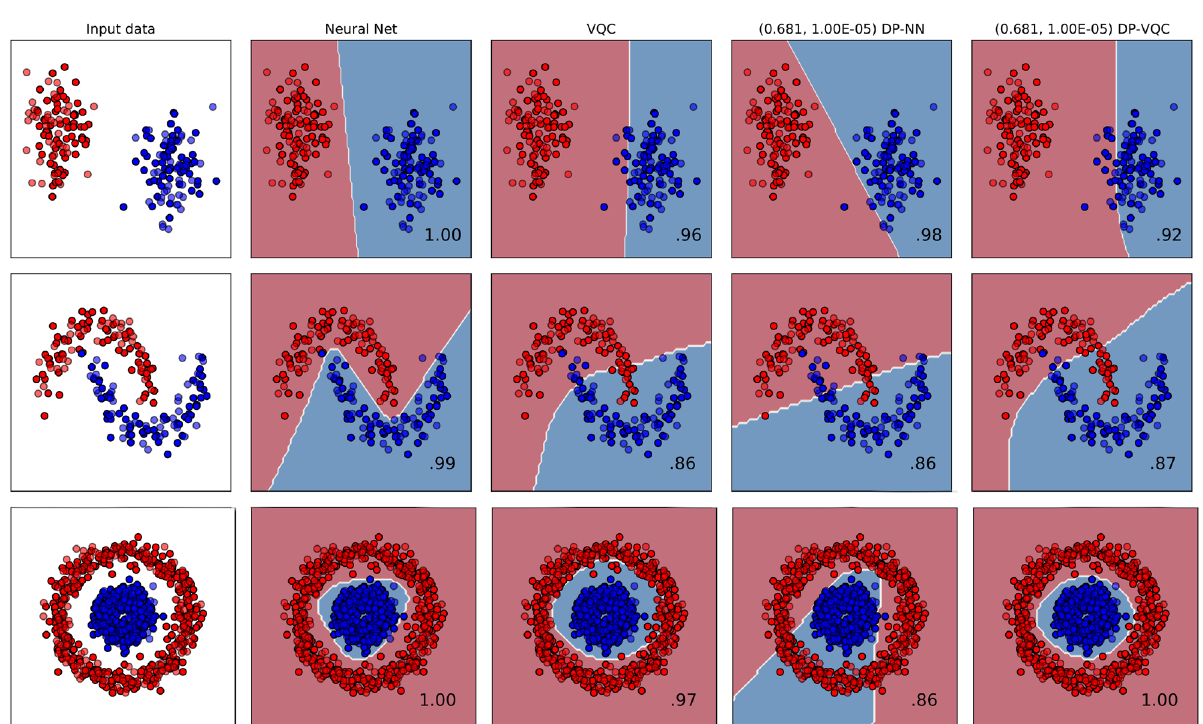
Figure 10. Results from the 2D ML experiments. The first column shows the three input sets, which are the “blobs”, “moons”, and “circles” datasets going down. The subsequent columns show different models tasked with classifying and learning the decision boundary. The array of plots illustrates the decision boundaries formed by the different models. The solid points are those used in training, and the transparent ones are part of the testing set. Total accuracy after 30 epochs is displayed on the lower right of each plot. The first two datasets each contained 200 samples; the last dataset, i.e. “circles”, contains 1000